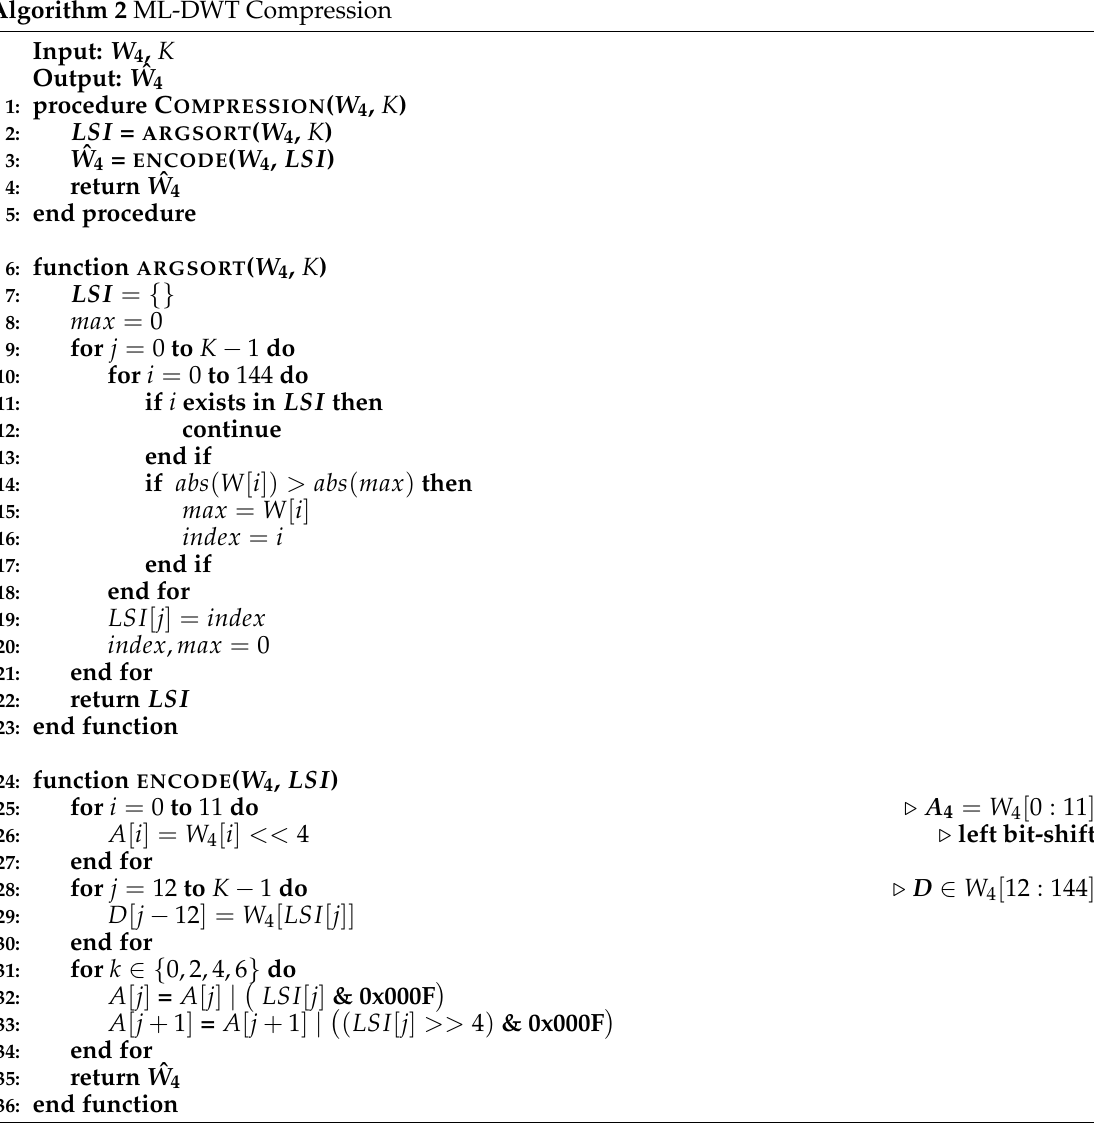
Algorithm 2 ML-DWT